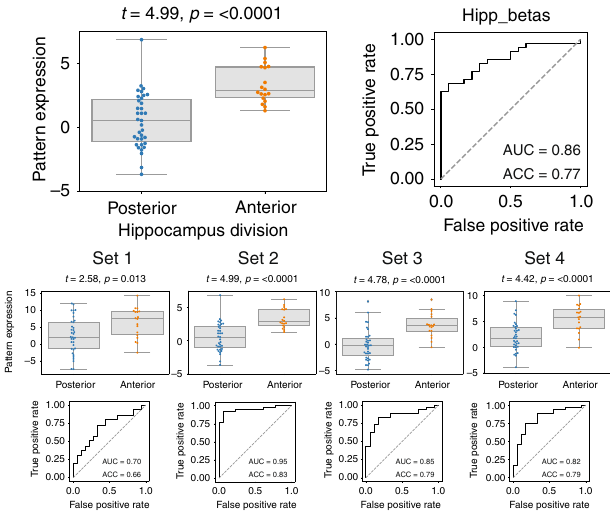
Fig. 3 Model trained on adult hippocampus predicts location of samples from prenatal hippocampus. The pattern of gene expression used to predict the location of adult hippocampus samples along the longitudinal axis were applied to samples extracted from the prenatal human hippocampus. Boxplots compare this normalized pattern of expression between samples extracted from the rostral and caudal hippocampus. Statistics are calculated using t -tests. ROC curves were generated using logistic regression. The top fi gures correspond to models fi t using all features, whereas the bottom fi gures correspond to models fi t using the smaller gene sets. ACC Accuracy. AUC Area Under the Curve. For boxplots, the center line, boxes and whiskers represent the median, inner quartiles, and rest of the data distribution (except outliers),